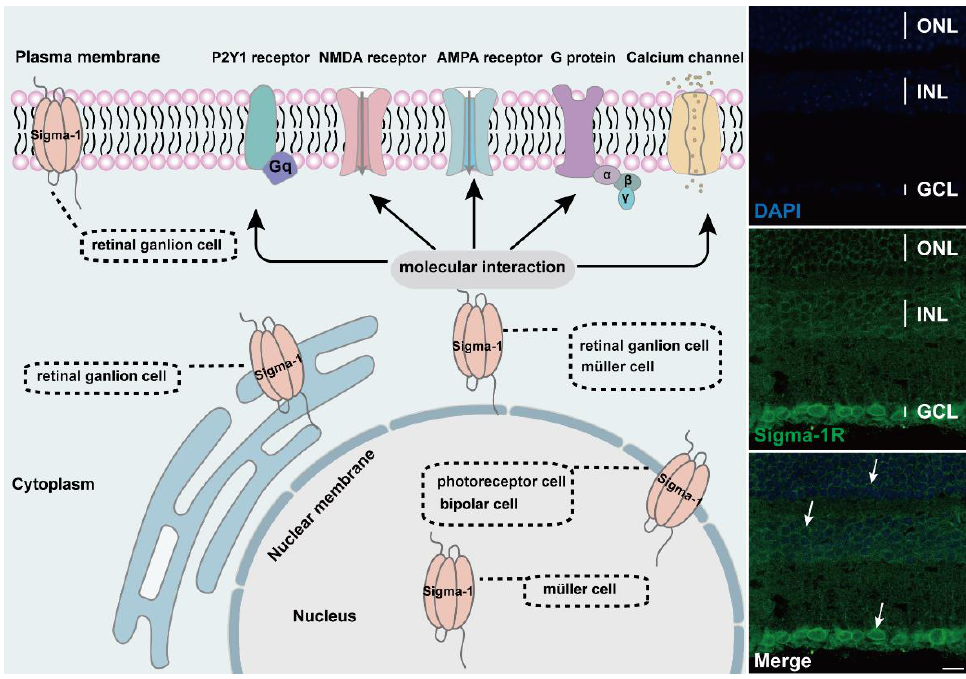
Figure 2. Diagram of subcellular distribution and molecular interaction of sigma-1 receptors in retina. The expression of sigma-1 receptors in mouse retina by immunofluorescence was shown on the right side of schematic. Confocal scanning showed that sigma-1 receptor mainly expressed in nuclear membrane in ONL, INL, and GCL and the signals were labeled with white arrows.